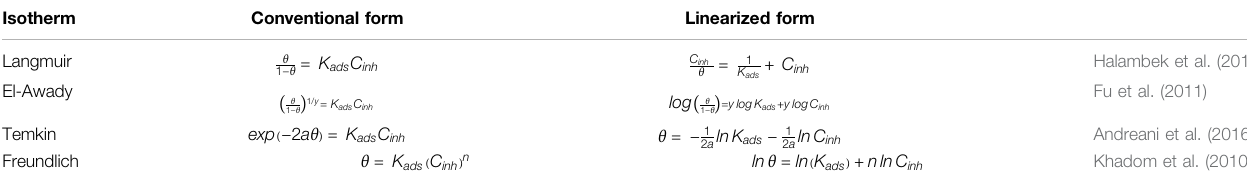
TABLE 4 | Linearized and conventional and forms of the most used adsorption isotherm models.